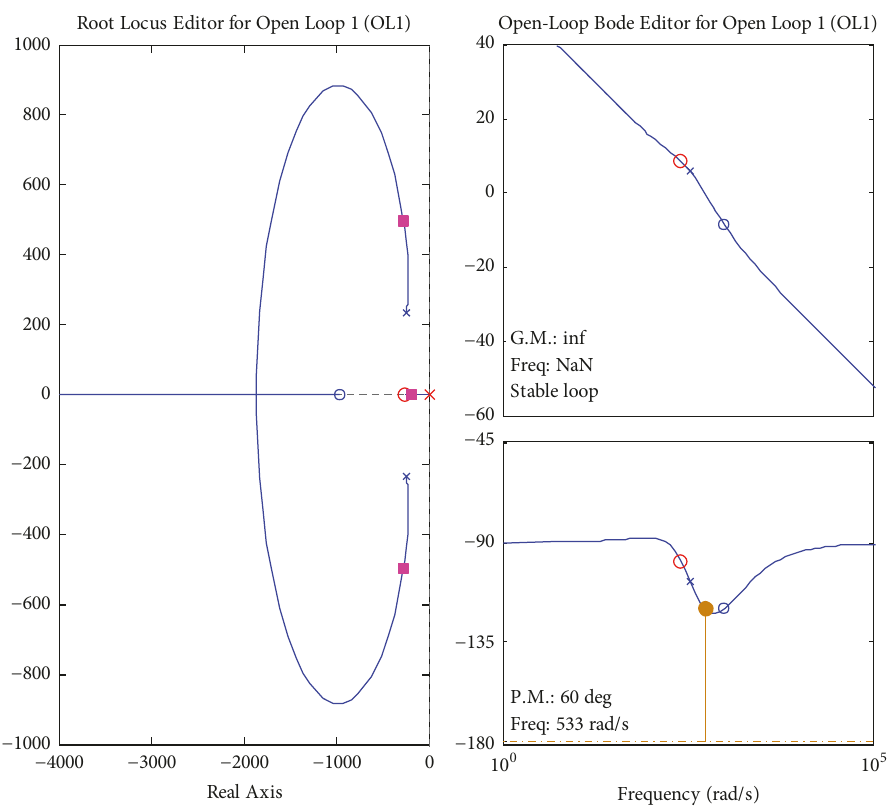
Figure 7: Root locus and open loop bode plots for the inner loop of boost converter.